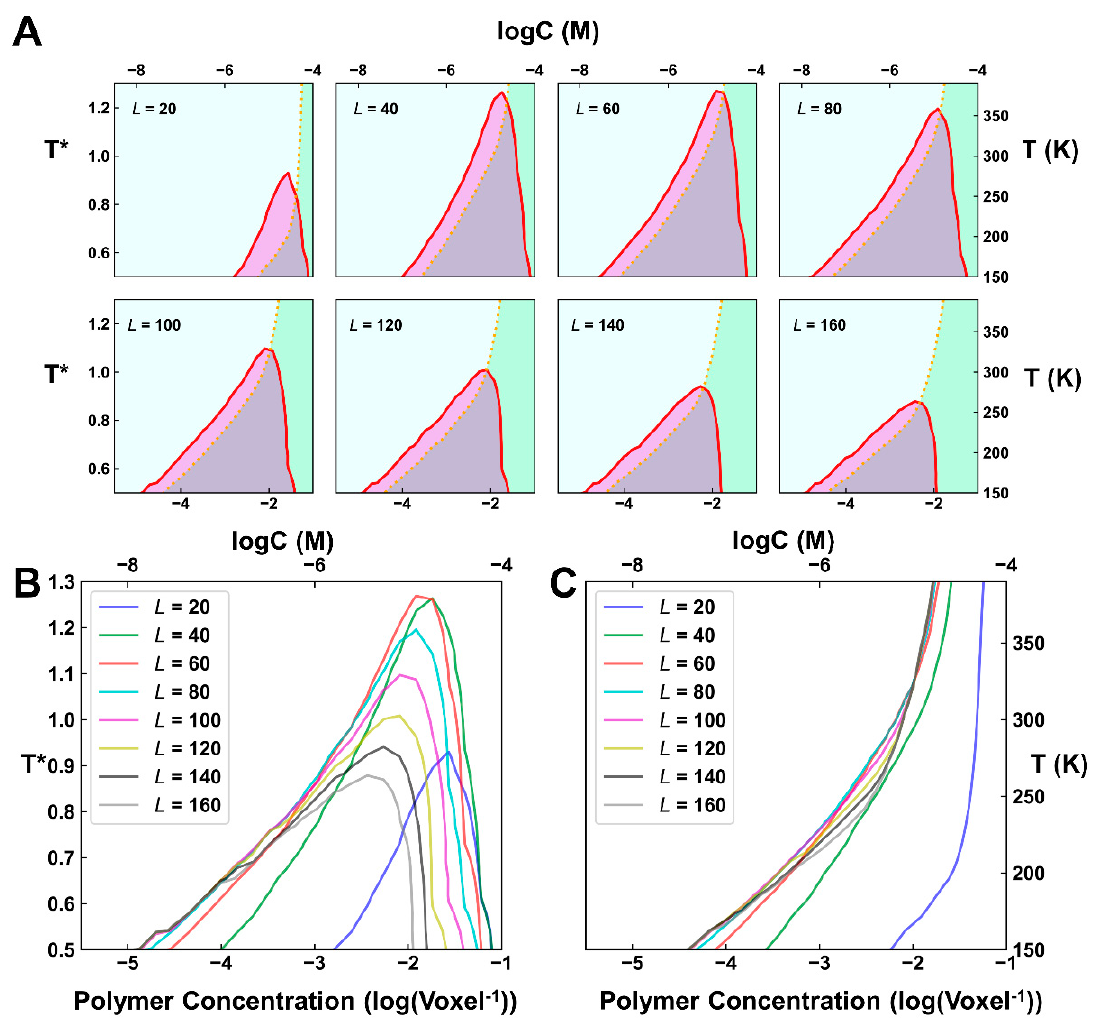
Figure 4. Influence of the neutral-linker length on the simulated phase behaviors. ( A ) Phase diagrams of the systems with different linker lengths ( L = 20 ∼ 160). The red line shows the contour of ρ = 0.025 and the orange dotted line indicates the contour of φ C = 0.5. The left cyan area indicates solution phase; the right green phase indicates gelation phase; the purple area indicates phase separation without gelation and the grey area indicates phase separation with gelation. T ∗ = T / T 0 refers to the reduced temperature. ( B , C ) Contour of ρ = 0.025 ( B ) and φ C = 0.5 ( C ) for